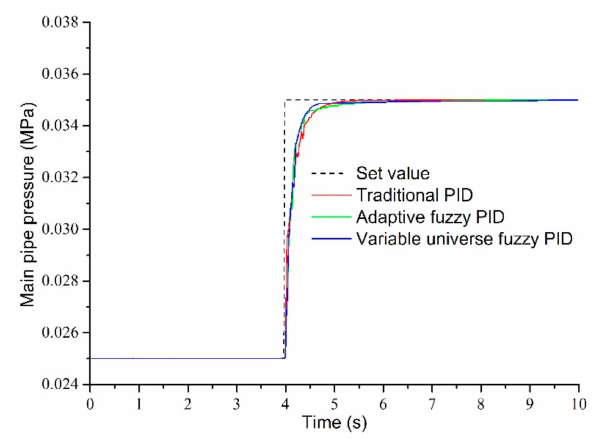
Figure 13. Step response curve.